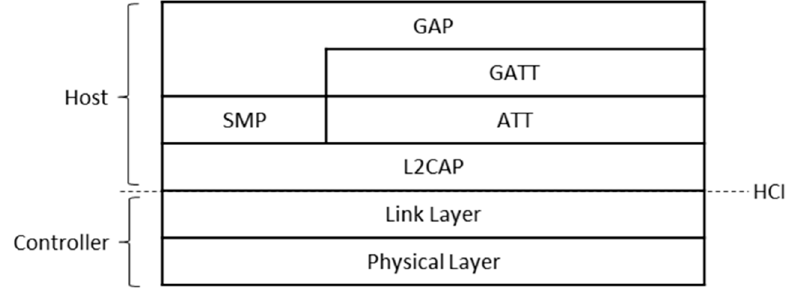
Figure 1. Bluetooth Low Energy protocol stack.